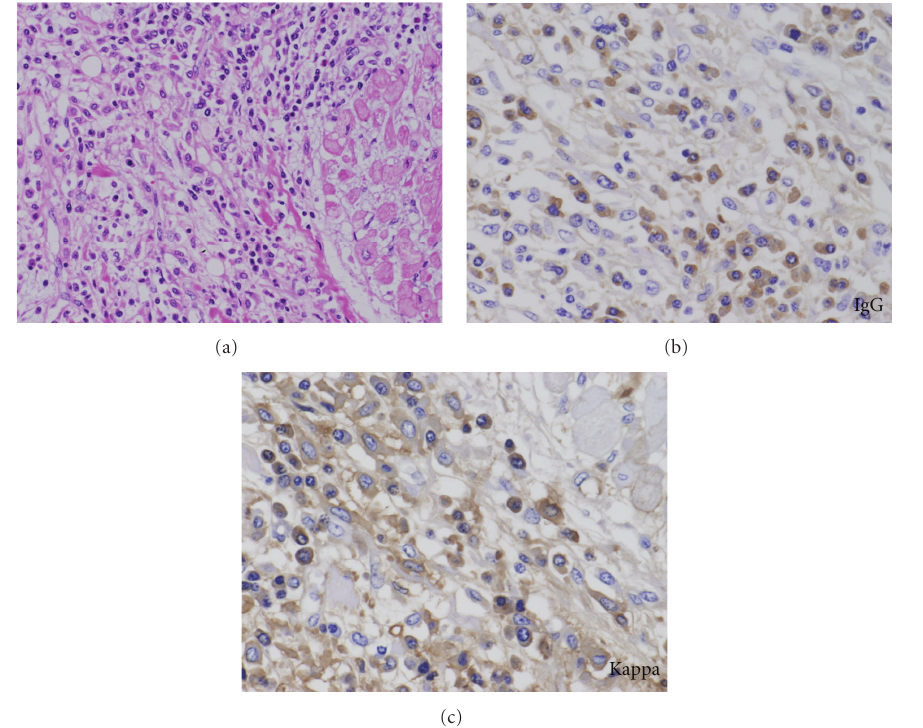
Figure 6: Microphotograph of the heart illustrating plasma cell invasion. Note prominent plasma cell proliferation in the region of the epicardium (a) (hematoxylin-eosin, original magnification × 200). Immunohistochemically, the plasma cells are positive for IgG (b) and kappa-light chain (c) (original magnification, × 400, resp.).